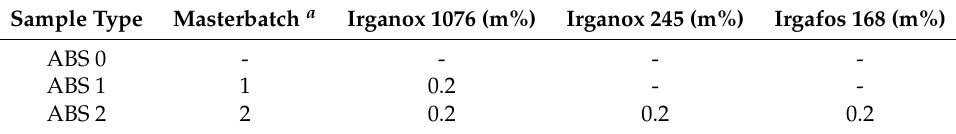
Table 1. Final mass contributions of stabilizers in sample types for first injection molding